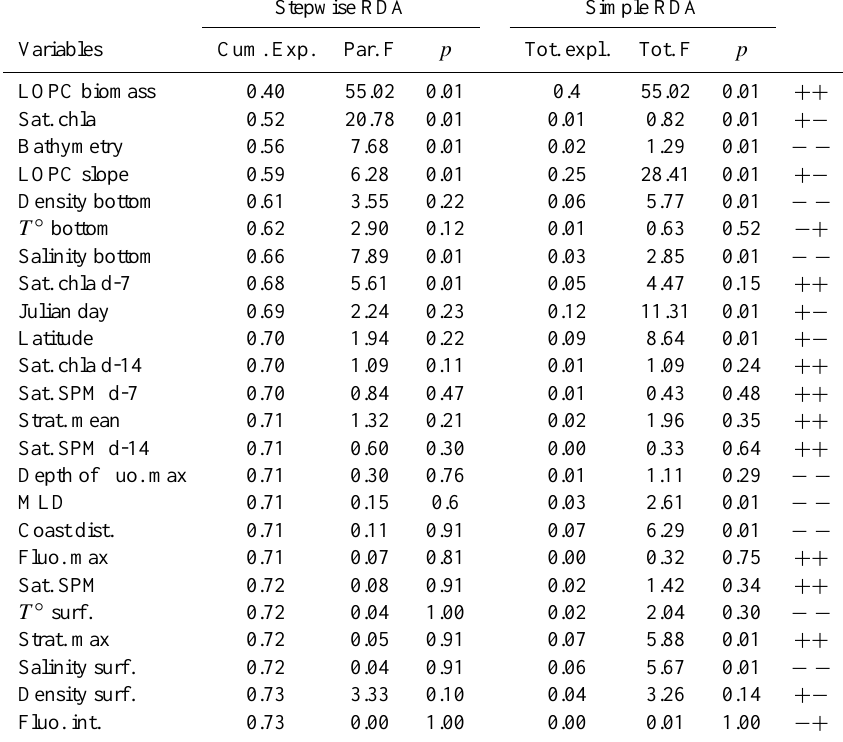
Table 2. Results of the stepwise redundancy analysis (RDA) and simple RDA performed on residuals from NBSSs of [LOPC-WP2/Zs]. Par. F = partial F statistic; Cum. Exp. = cumulative fraction of variance explained; Tot. Expl. = fraction of the total variance explained; Tot. F = total F statistic; p = p values for significance of the F statistic; Sat. = Satellite; surf. = surface; bottom = 100m depth or maximum depth of the profile; strat. = stratification; T ◦ = temperature; Sal. = salinity; chla = chlorophyll a ; Fluo. = fluorescence; Depth of fluo. max = depth of the maximum value of fluorescence; MLD = mixed layer depth; SPM = suspended particulate matter; Int. = Integrated value from surface to bottom depth; max = maximum value observed between surface and bottom depth; d-7/14 = Satellite data 7 and 14 days before the sampling date; Coast dist. = distance to the coast. The last column represents the sign of the correlation between the slope and the intercept of the residuals (i.e., the non-living matter), respectively; e.g., Sat. chla is positively correlated to the slopes but negatively to the intercepts. Stepwise RDA Simple RDA Variables Cum. Exp. Par. F p Tot. expl.